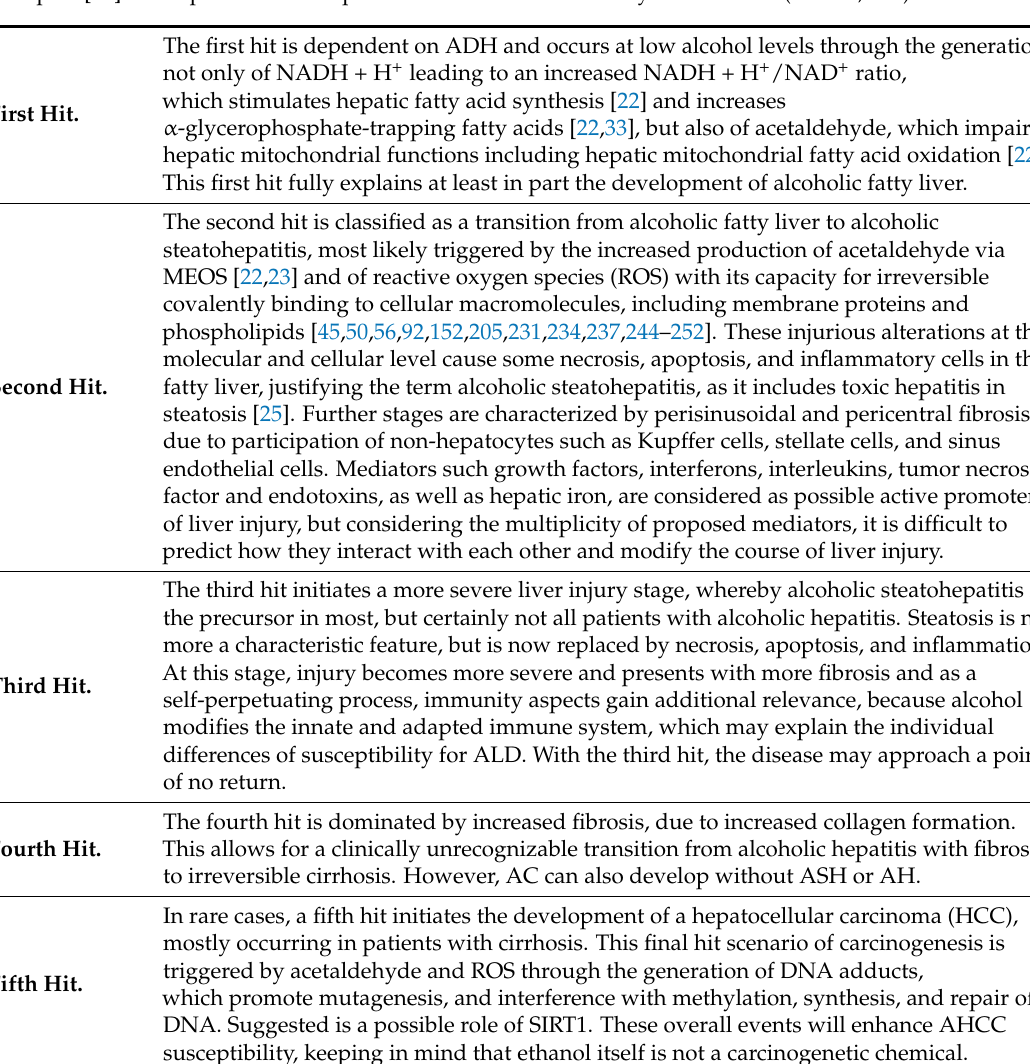
Table 4. Alcoholic liver disease and the 5-hit working hypothesis with a tentative cascade of events. Hypothetical steps of the five hits leading to end-stage alcoholic liver disease. Adapted from a previous report [25] and reproduced with permission of the PublisherTaylor & Francis (Didcot, UK).